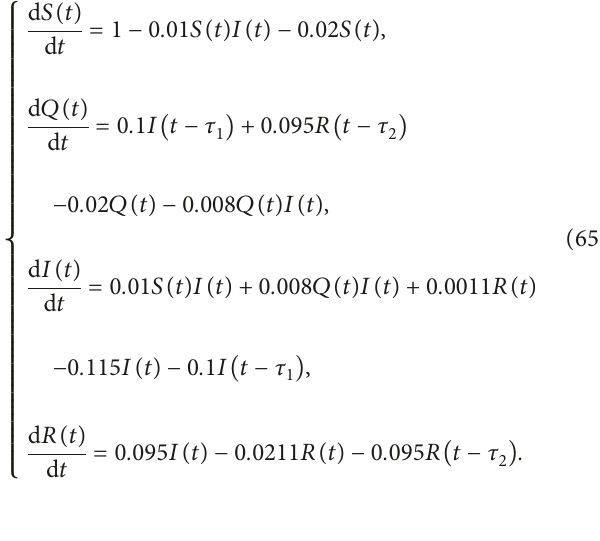
� 7 . 75 ∈ ( 0 , τ and τ 2 ∗ 1